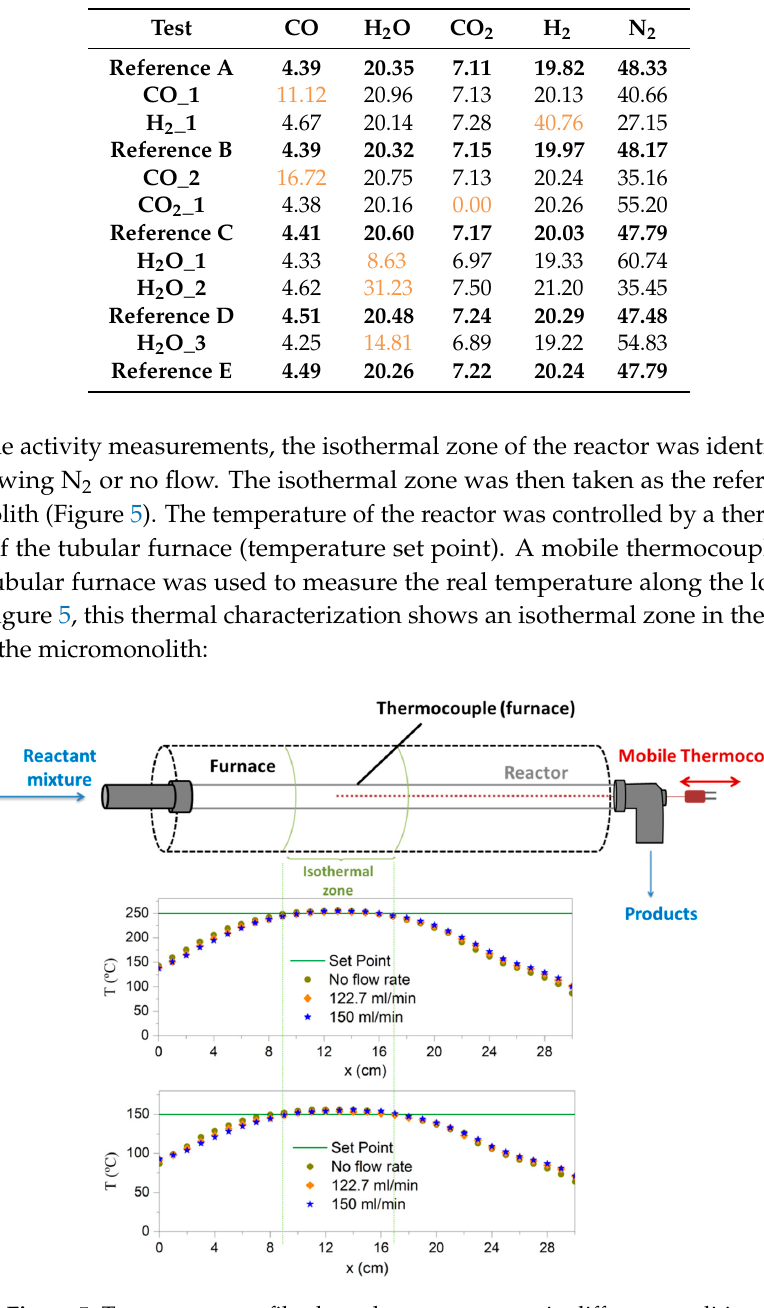
Figure 5. Temperature profile along the empty reactor in different conditions.